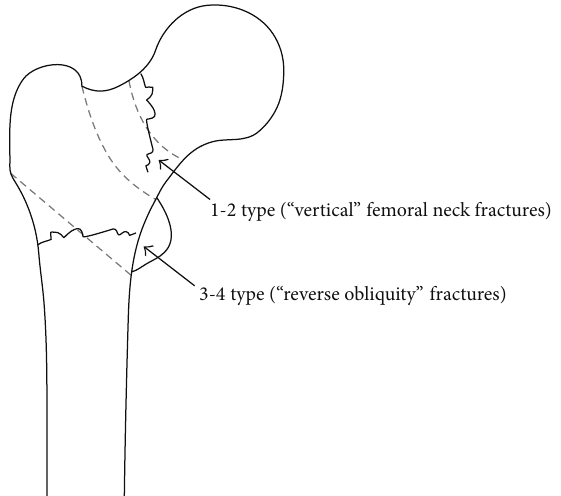
Figure 3: The “dangerous” fractures that exceed each classification’s particularzones.Forexample,1-2typefracturesareverticalfractures that extend to the basal neck from the neck. 3-4 type fractures are equivalent to type 2 of the Evans classification; their instability is greater than general trochanteric fractures.